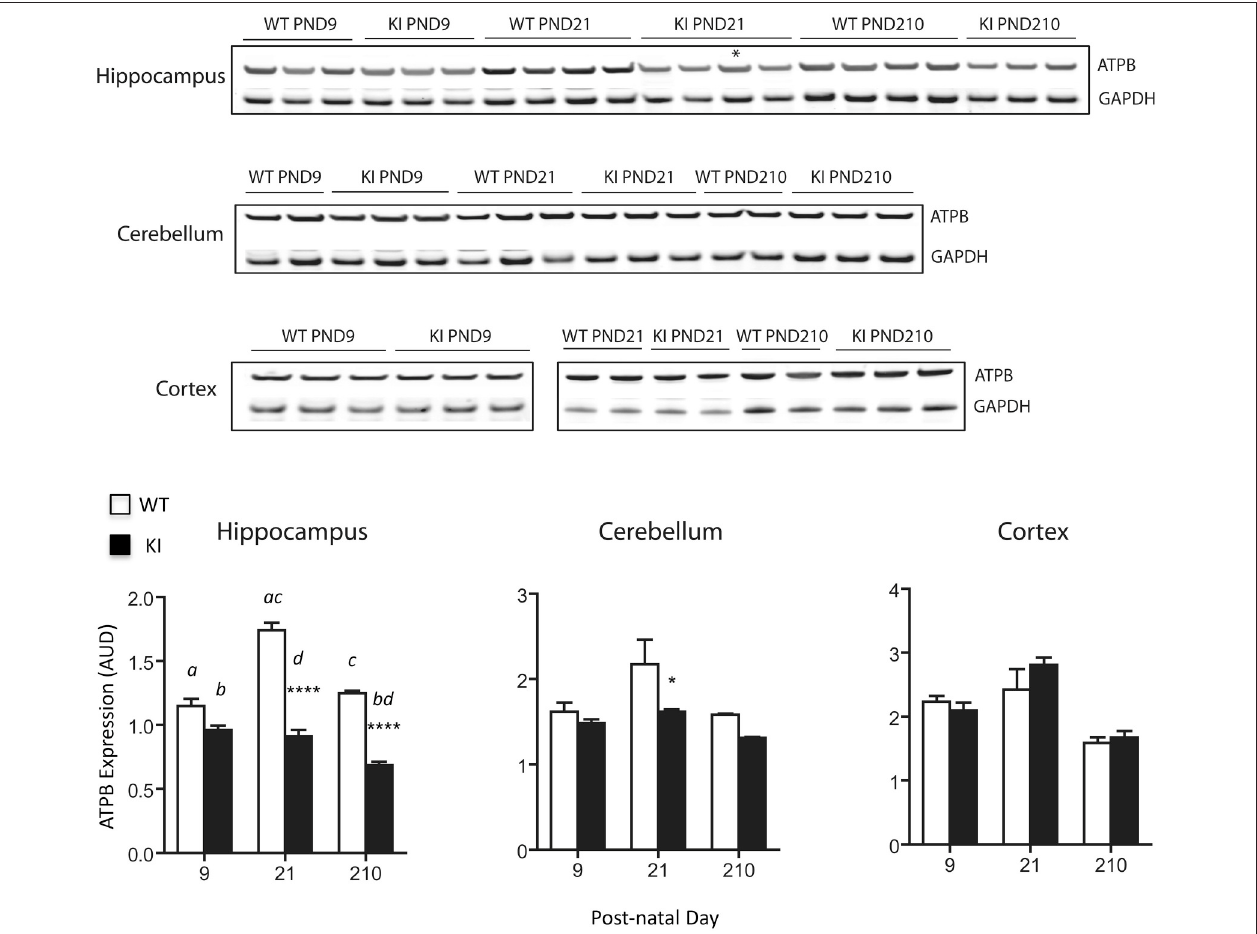
FIGURE 3 | Protein expression levels of mitochondrial ATPase β -subunit in brain from KI mice. ATPase β -subunit protein expression (normalized to GAPDH) was evaluated at PND9, 21 and 210 in hippocampus, cerebellum, and cortex lysates. Asterisk in the immunoblot image of hippocampus denotes a 90 CGG KI sample. Densitometry data for this sample have not been taken into account for averages calculation of KI. Cortex samples were ran in two different gels (PND9 and PND21-210) and are shown separately. Data are reported as mean ± SEM, n = 3–5 per genotype per time point, ran in triplicates. Statistical analysis was performed by Two-way ANOVA. Post-hoc analysis was performed by Tukey’s HSD test for multiple comparisons. Significant difference between WT and KI are indicated by asterisks as follows. **** p < 0.0001; * p < 0.0492. Statistically significant differences among time points are indicated by letters as follows: p < 0.0001 ( a, c ), p